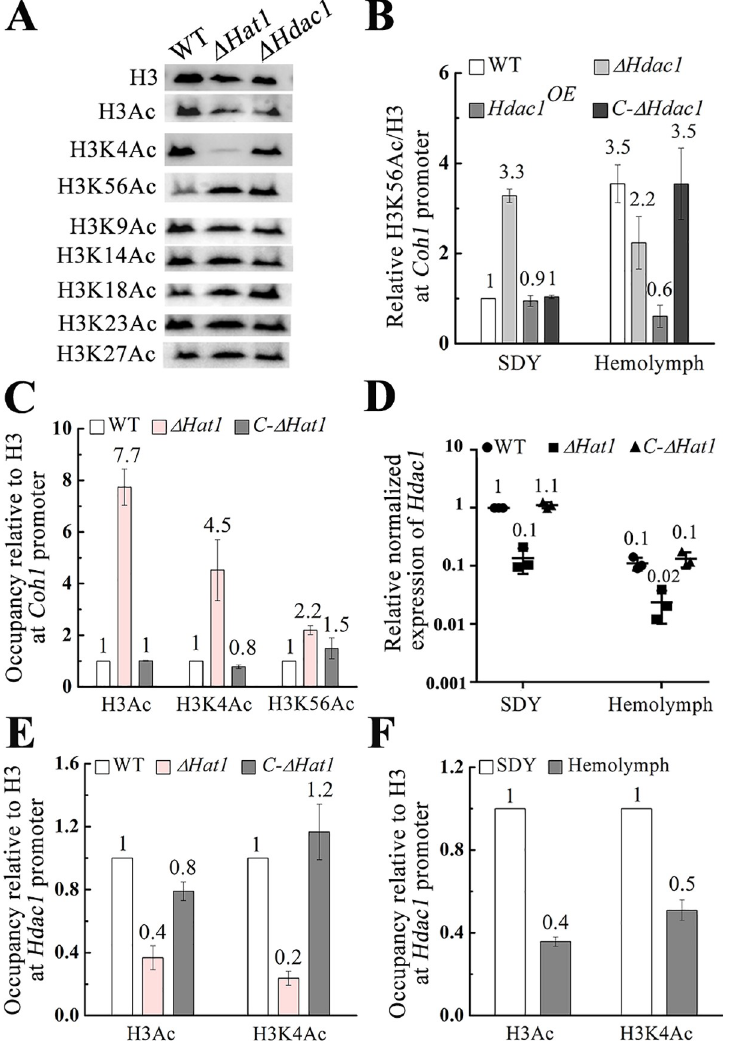
Fig 2. HDAC1 and HAT1 control Coh1 expression by regulating histone H3 acetylation in its promoter region. (A) Immunoblot analysis of acetylation levels of 7 lysine residues on histone H3 protein in the wild-type (WT) strain and the mutants Δ Hdac1 and Δ Hat1 . All Western blot images shown in this study are representatives of at least 3 independent experiments. (B) The acetylation level of H3K56 in the Coh1 promoter in the mutant Δ Hdac1 , its complemented strain C- Δ Hdac1 , the Hdac1 -overexpressing strain Hdac1 OE , and the WT strain during saprophytic growth in Sabouraud dextrose broth supplemented with 1% yeast extract (SDY) and surrogate hemocoel colonization (Hemolymph). (C) The acetylation levels of histone H3, H3K56, and H3K4 in the Coh1 promoter in the mutant Δ Hat1 and its complemented strain C- Δ Hat1 relative to the WT strain during saprophytic growth. (D) qRT-PCR analysis of Hdac1 expression in the WT strain, the mutant Δ Hat1 , and its complemented strain C- Δ Hat1 during saprophytic growth and surrogate hemocoel colonization. (E) The acetylation levels of histone H3 and H3K4 in the Hdac1 promoter in the mutant Δ Hat1 and its complemented strain C- Δ Hat1 relative to the WT strain during saprophytic growth. (F) The acetylation levels of histone H3 and H3K4 in the Hdac1 promoter in the WT strain during surrogate hemocoel colonization relative to saprophytic growth. For chromatin immunoprecipitation quantitative PCR AU : Pleasecheckthattheeditstothesentence } ForchromatinimmunoprecipitationquantitativePCR ::: } captureyourmeaning : Ifnot ; pleaseprovidecorrectwording : (ChIP- qPCR) analyses in this figure, the values represent the fold-change of the acetylation level of histone H3, H3K4, or H3K56 compared with the level in its respective control, which is set to 1. All ChIP-qPCR experiments were repeated at least 3 times. The data underlying all the graphs shown in this figure can be found in S1